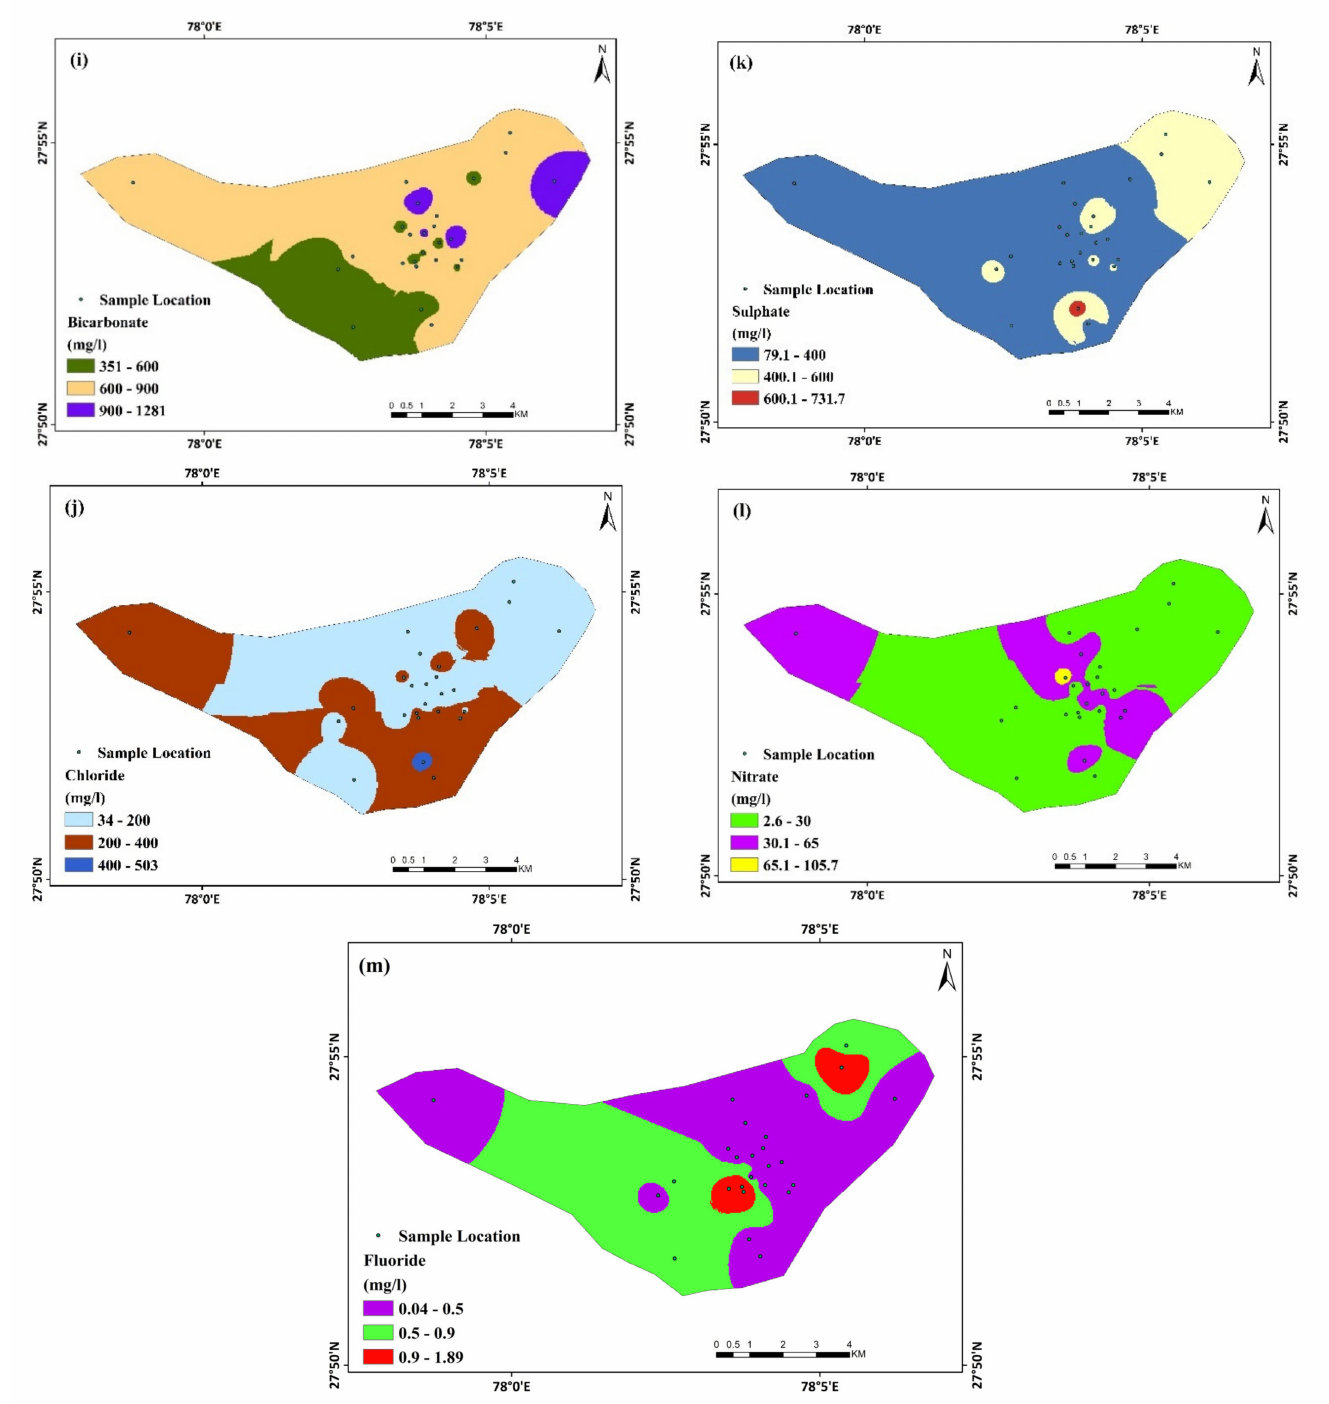
Figure 2. Spatial distribution of different physiochemical parameter ( a ) pH ( b ) Electrical Conduc- tivity ( c ) Hardness ( d ) Total Dissolved solids ( e ) Sodium ( f ) Calcium ( g ) Potassium ( h ) Magnesium ( i ) Bicarbonate ( j ) Chloride ( k ) Suphate ( l ) Nitrate ( m ) Fluoride in the study area. The TDS values varied between 313 mg/L to 2554 mg/L with an average of 933 mg/L, and the TDS results revealed three samples below the 500 mg/L except for a high value in Shaktinagar (2554 mg/L), and other samples showed a moderate range. In addition, TDS is the total of carbonates, potassium, calcium, chlorides, sodium, bi-carbonates, phosphate, magnesium, and other particles. The dominance of groundwater samples is found